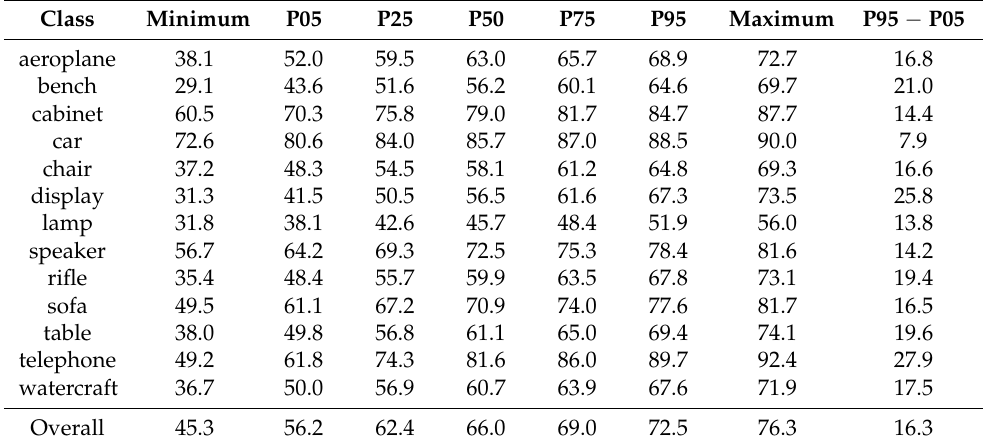
Table 6. Percentiles P, minima and maxima of IoU values obtained from all combinations of 3 viewpoints. The last column indicates the difference between P05 and P95. One quarter of the combinations have similar or higher IoU than the results presented in Table 2 for 8 viewpoints. We also see a large variation between best and worst